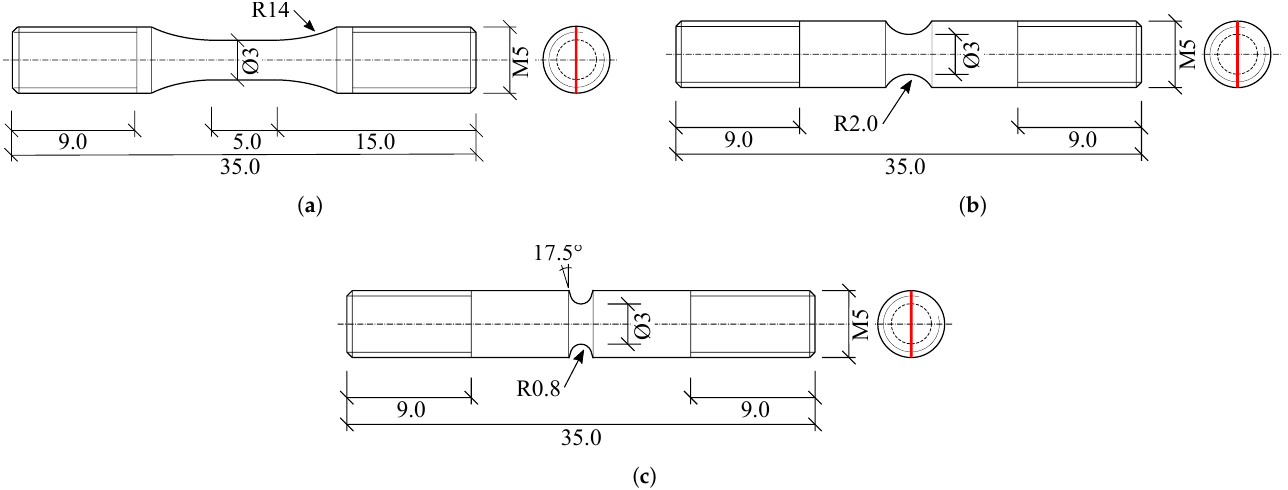
Figure 2. Nominal geometries of the ( a ) smooth, ( b ) notch R2.0 and ( c ) notch R0.8 tension test specimens. The red line in the rightmost figure in each sub-figure represents the ND of the extruded profile, and was marked physically on the specimens. All measures are in